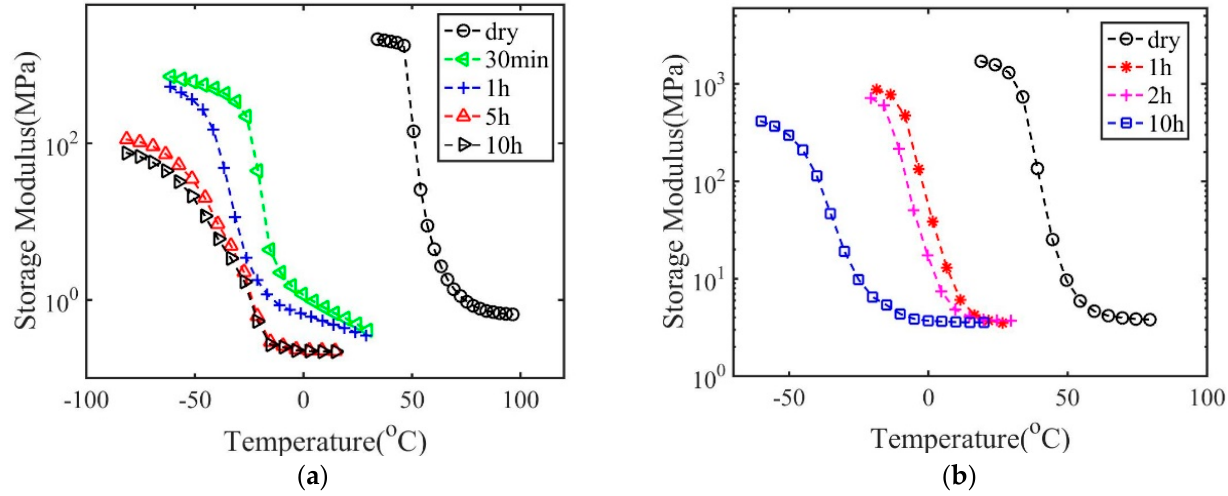
Figure 5. The storage modulus as a function of temperature of ( a ) polymers with 2 wt.% crosslinking density and ( b ) 20 wt.% crosslink density and treatment in isopropyl alcohol ( IPA) for different times.